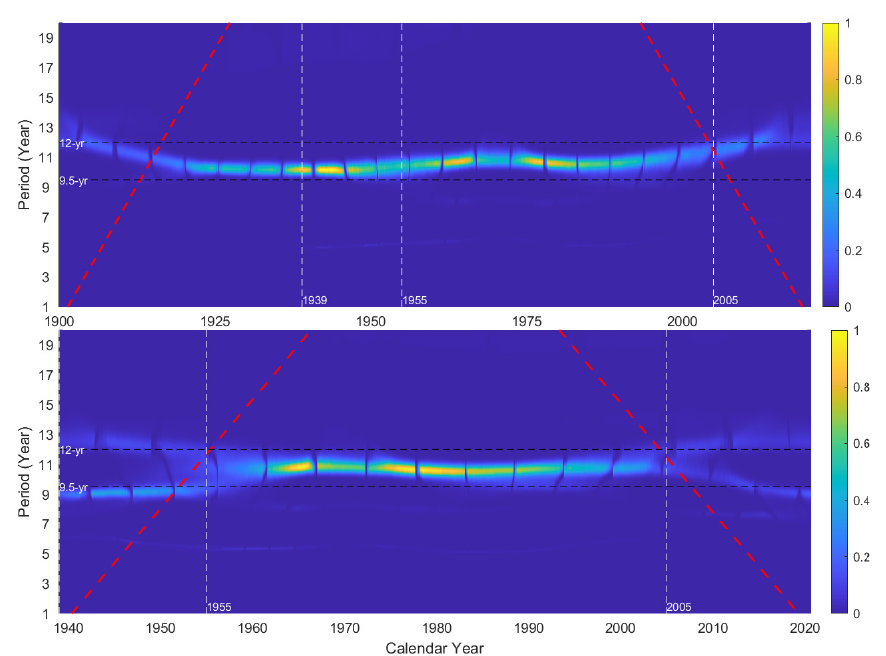
Figure 5. Time–frequency representation of the sunspot numbers data with different length of series. The dashed red lines are the cone of influence (COI). ( Upper panel ): series from 1 January 1900